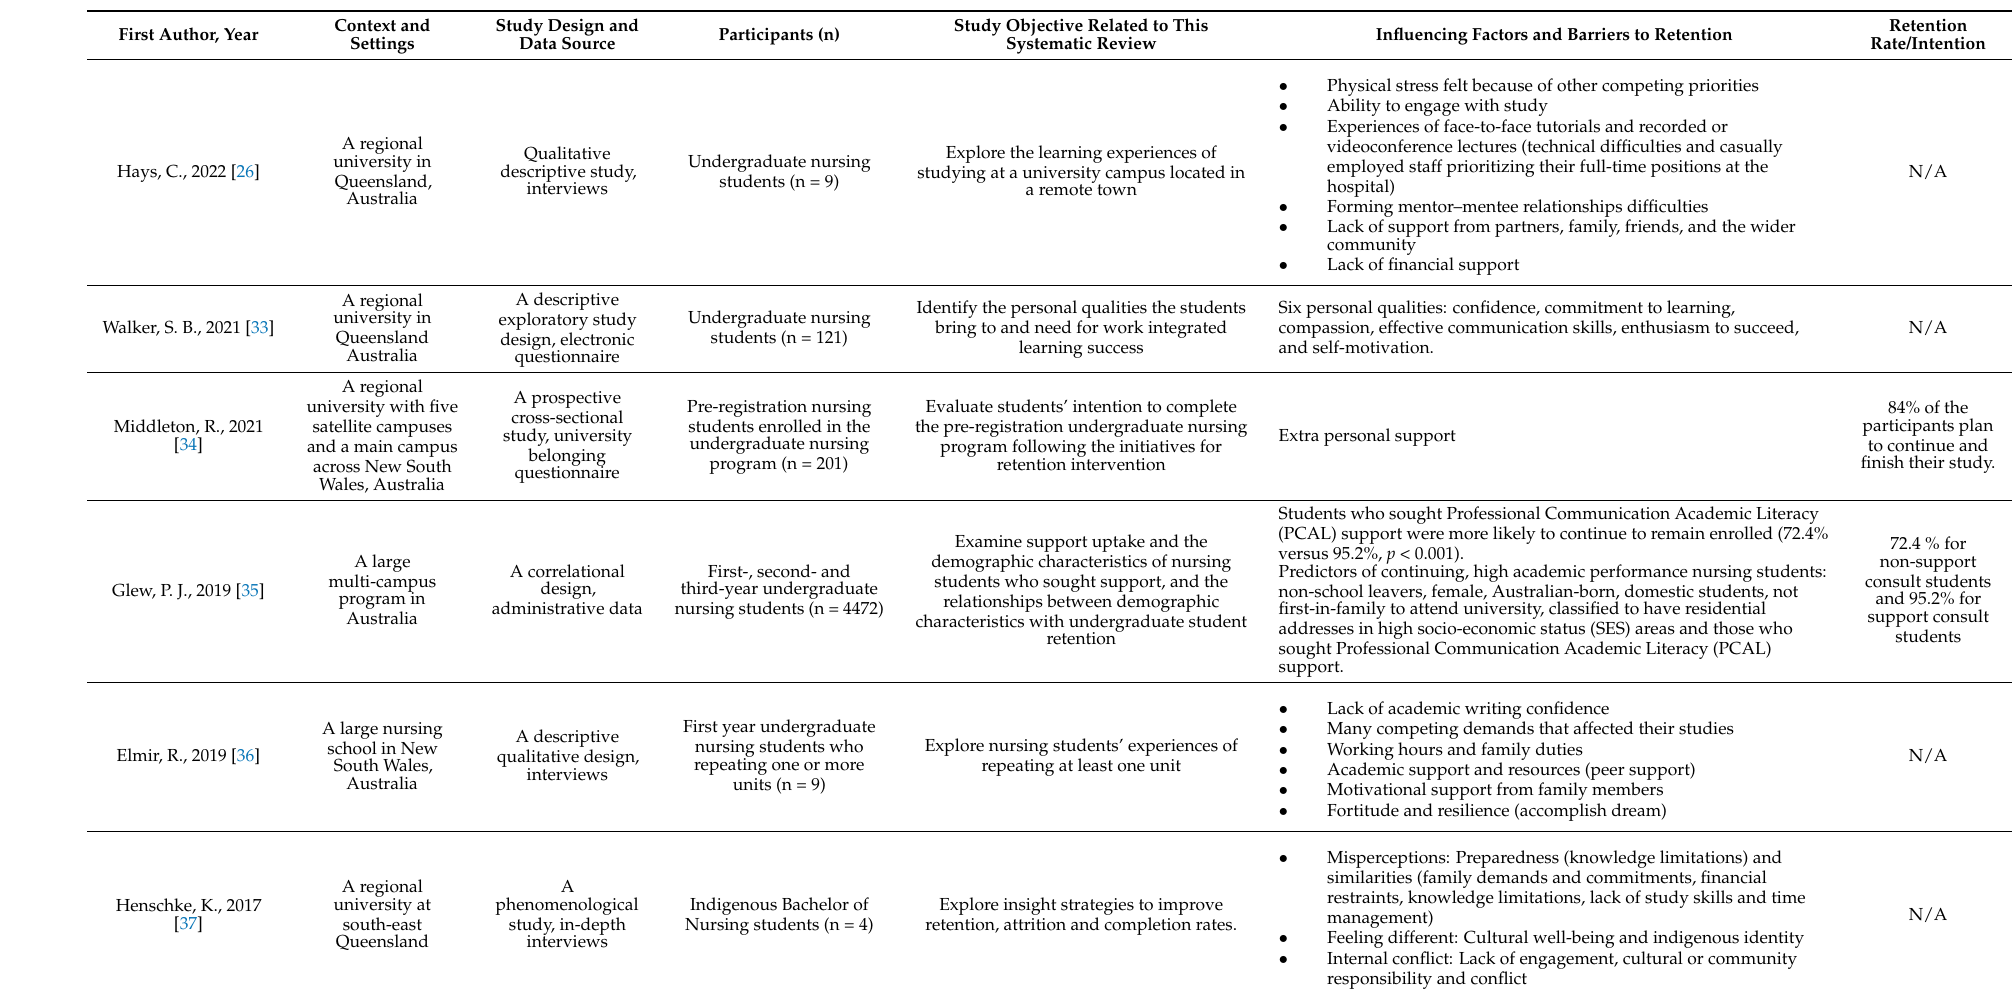
Table 1. Characteristics of the included